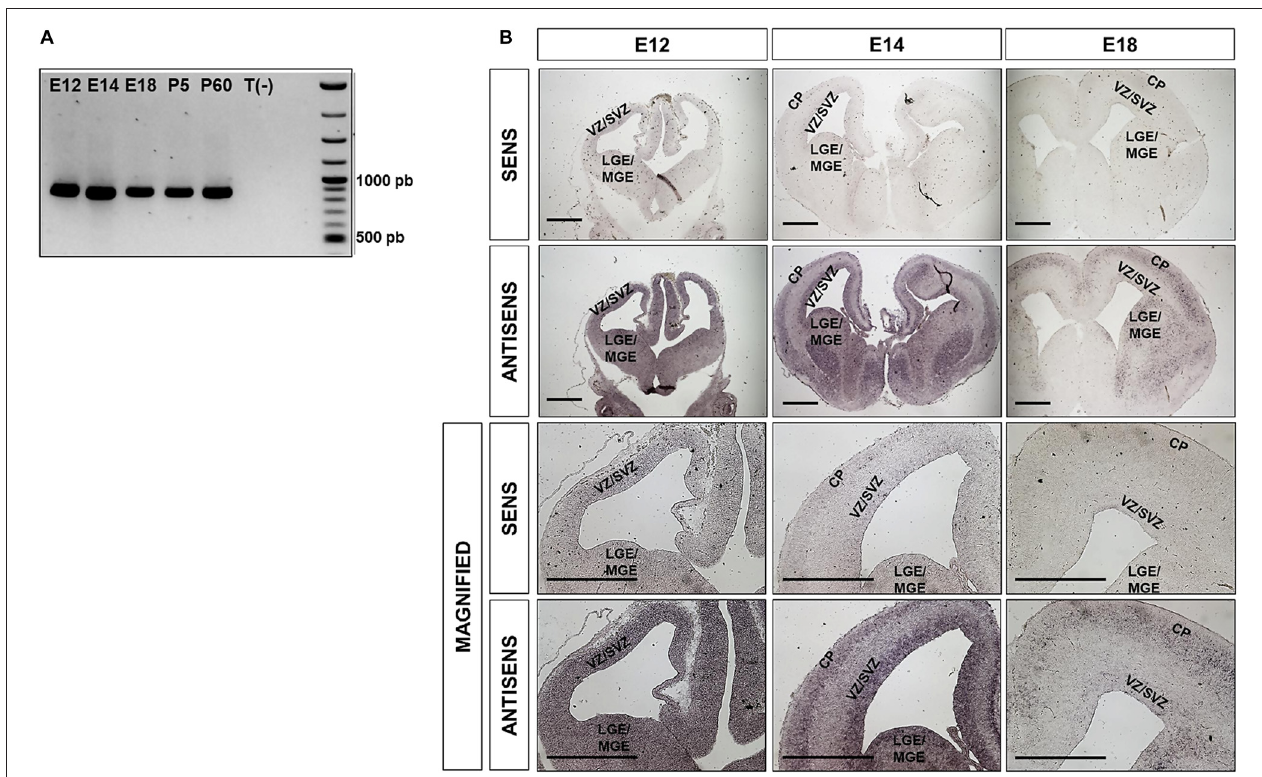
FIGURE 1 | Ipo8 mRNA is expressed in both the developing and the adult mouse brain (A) . RT-PCR analysis in whole brains at different embryonic (E12, E14, E18) and post-natal (P5, P60) ages. T(-) is a negative control that corresponds to a PCR performed in absence of cDNA. The expected band size is 883bp. (B) . Ipo8 mRNA distribution in the developing brain visualized by in situ hybridization (ISH). At E12, mRNA is detected in many regions including LGE/MGE and the VZ/SVZ of the cortex. At E14 and E18, a signal is observed in the LGE/MGE, VZ/SVZ and cortical plate (CP) but tends to decrease with ages. LGE/MGE, lateral/median ganglionic eminence; VZ/SVZ, ventricular/subventricular zone (SVZ); CP, cortical plate. Scale bar: 1000 µ